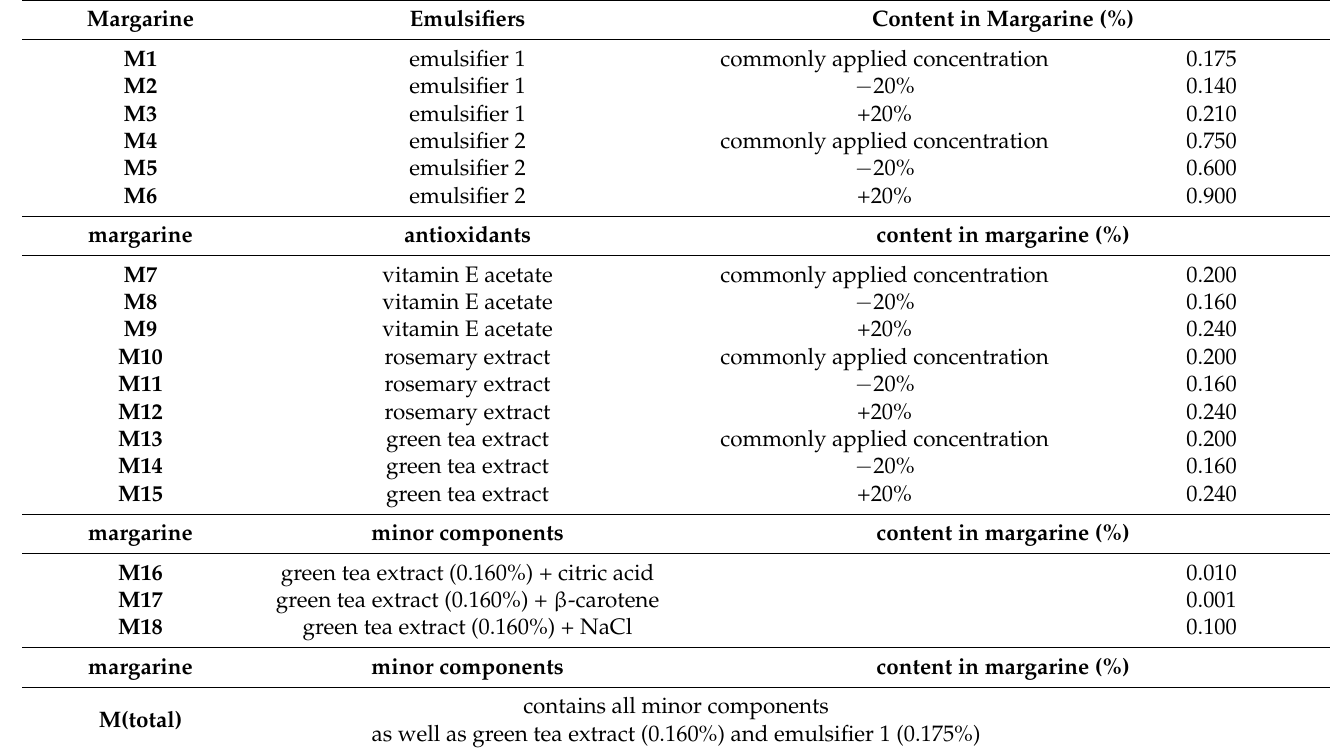
Table 1. Composition of different margarines. Samples M7-M18 consist of the commonly applied concentration of emulsifier 1 with